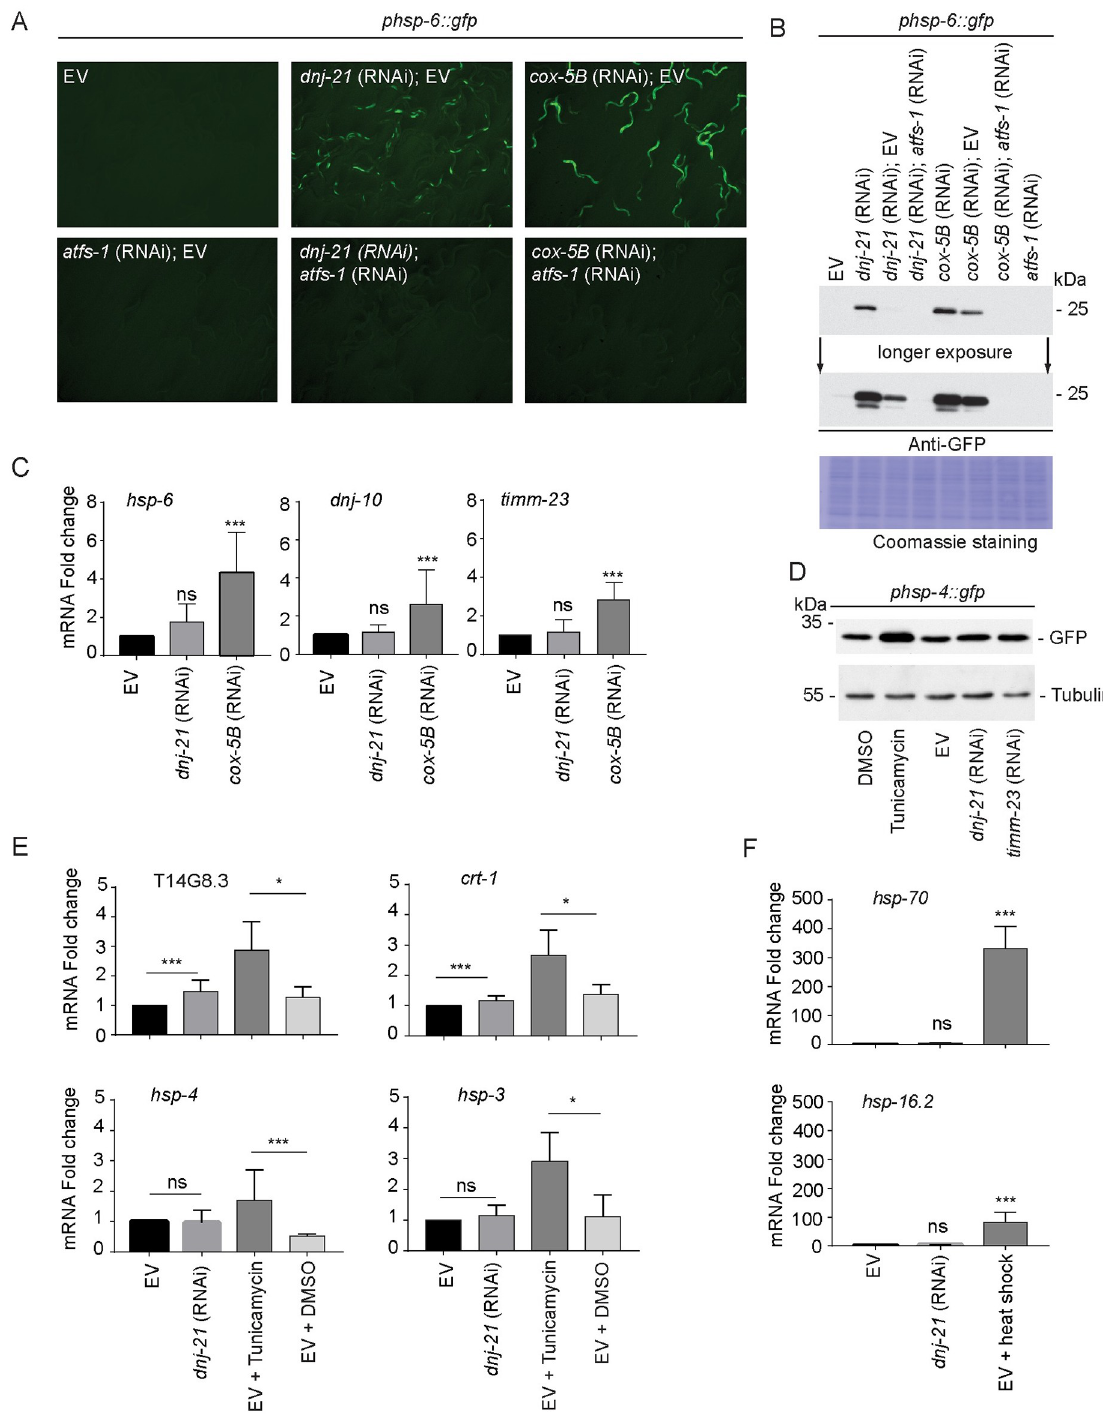
Fig 3. Depletion of DNJ-21 activates some features of transcriptional unfolded protein responses. (A, B) Worms that expressed hsp-6p :: gfp , a transcriptional reporter for activation of the UPRmt, were kept starting at the embryonic stage on RNAi plates throughout the experiment. (A) Representative images of worms on the plate upon depletion of the indicated genes. Images were taken at the same magnification and exposure time when worms reached young adulthood. Microscopy analysis was repeated in 2 biological replicates. (B) Worms were collected when they reached young adulthood. Total worm lysate was separated by SDS-PAGE and analyzed by western blot with an antibody against GFP. Equal loading of proteins was assured by Coomassie staining. (C, E, F) RT-qPCR in wild-type worms that